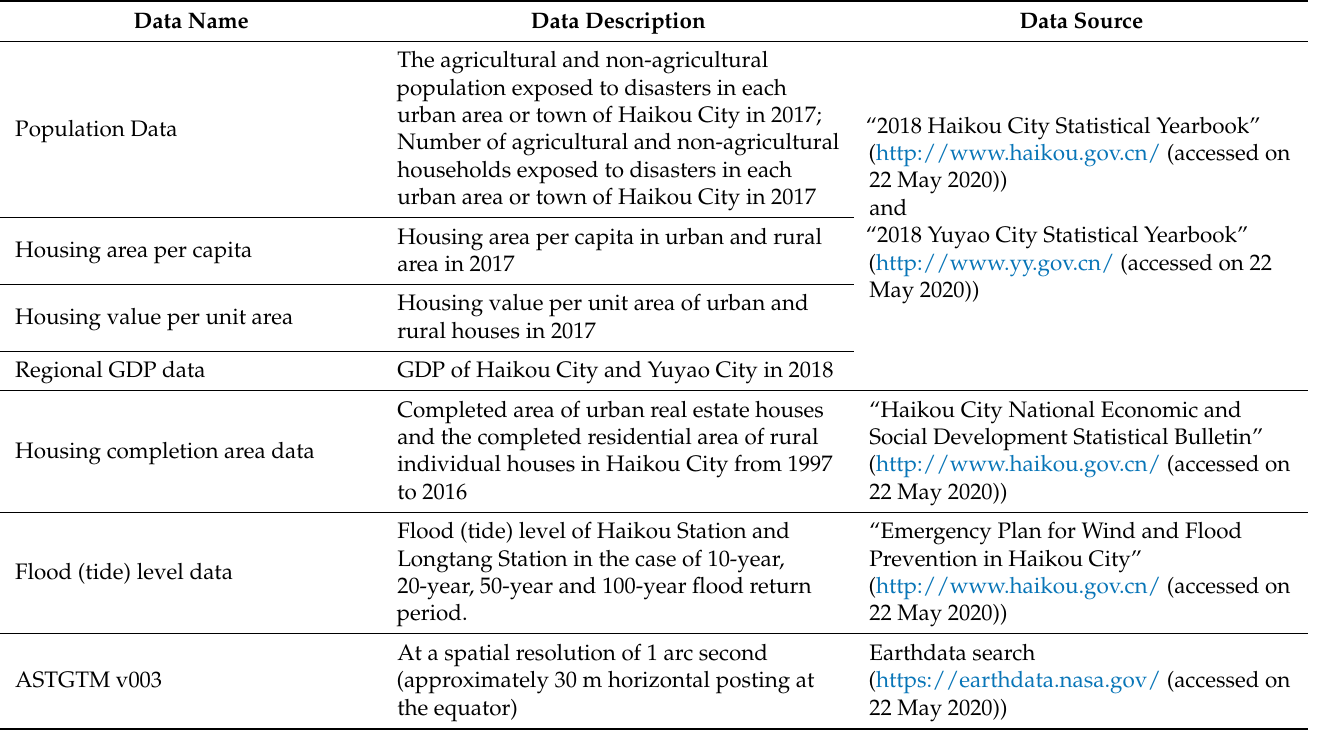
Table 1. Data and